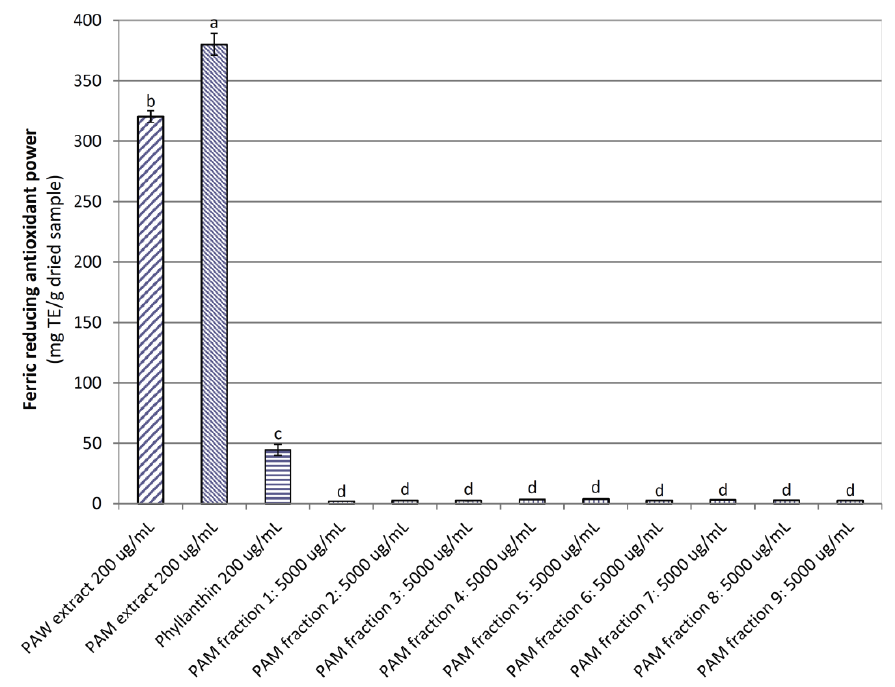
Figure 4. Ferric reducing antioxidant power of powdered the P. amarus water ( PA W) and methanol ( PA M) extracts and PA M fractions. Phyllanthin was used as a positive control. Different letters within the columns denotes a significant difference between treatments ( p < 0.05).